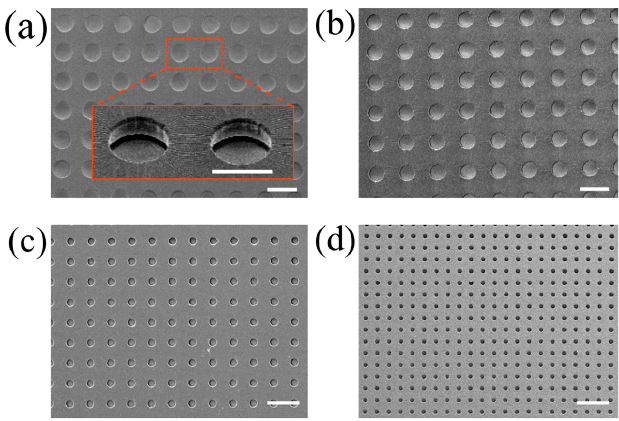
Figure 3. SEM images of the microwells. Top view images of ( a ) 120 μ m diameter wells (8457 total); ( b ) 100 μ m wells (13,232 total); ( c ) 50 μ m wells (34,344 total); and ( d ) 30 μ m wells (109,569 total); Inserted image in (a) was taken at 45°. Scale bar = 200 μ m for (a–d) and 120 μ m for insert in (a).